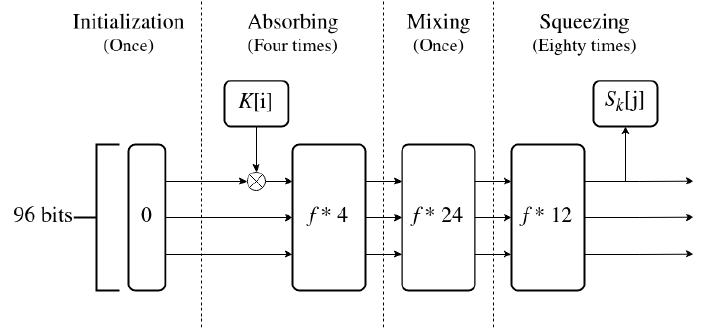
Figure 5. Sponge-based key expansion